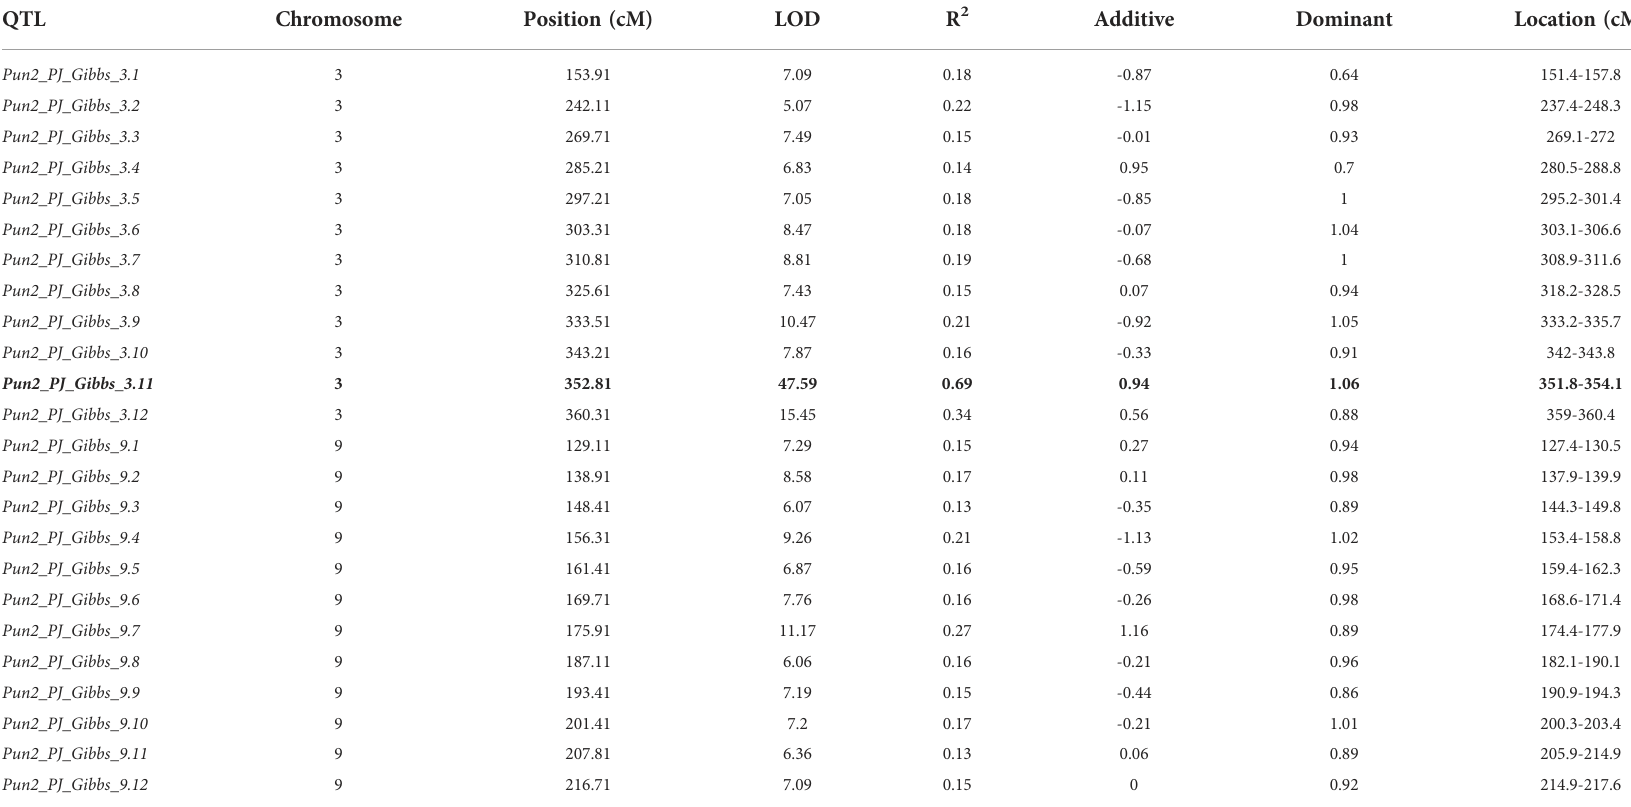
Bold values indicate the most dominant QTL with the highest LOD value among all detected